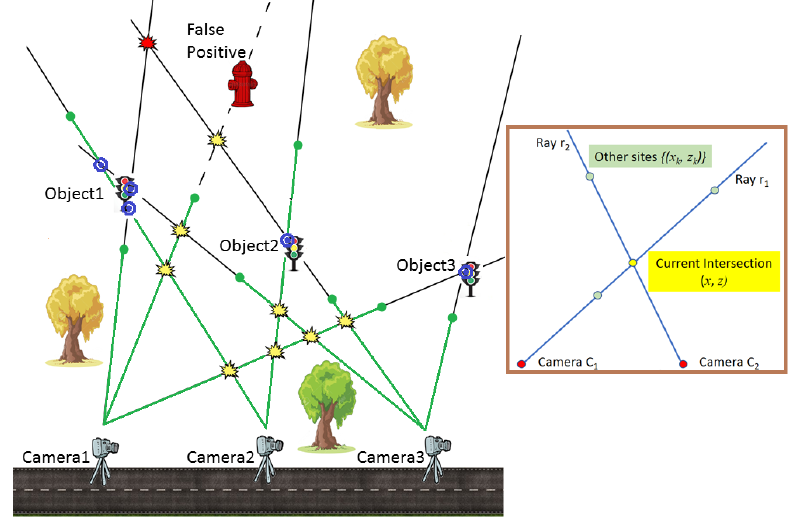
Figure 2. Object positions are identified based on triangulation of view-rays from camera positions. Depth estimates are demonstrated by green dots. An example of an irregular MRF neighbourhood is demonstrated in the side